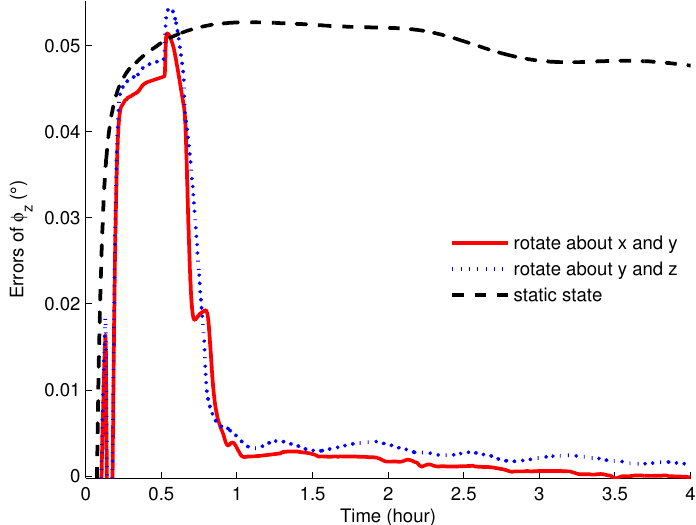
Figure 6. The estimated errors of the azimuth misalignment angles of rotation and static